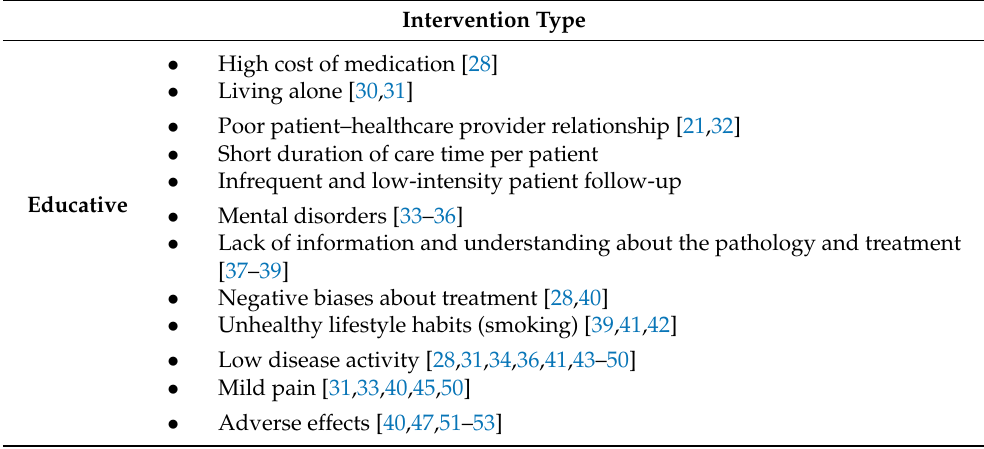
Table 5. Potential interventions to improve